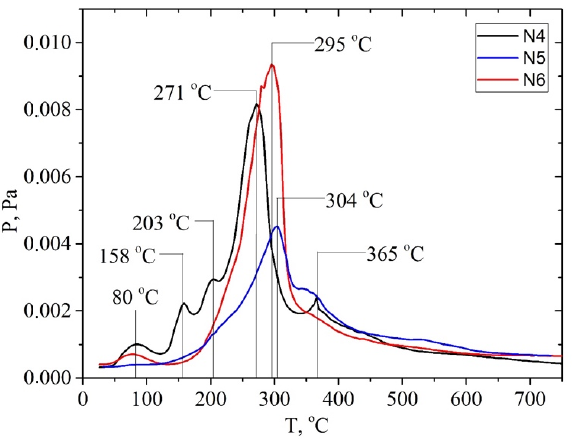
Figure 8. P/T curves of vapor pressure of gaseous products measured at temperature of pyrolysis: solids after hydrolysis of materials based on walnut shells: N4—solid after alkaline pretreatment; N5—solid after acid pretreatment; N6—solid after pretreatment with steam explosion. The P/T curve has overlapping peaks that correspond to the release of gaseous prod ‐ ucts due to thermal transformations of individual components of lignocellulose—hemi ‐ cellulose, cellulose, and lignin. Decomposing the P/T curve into separate Gaussians makes it possible to identify the main stages of pyrolysis at 81, 198, 309, 348, and 615 °C, etc., (Figure 9).